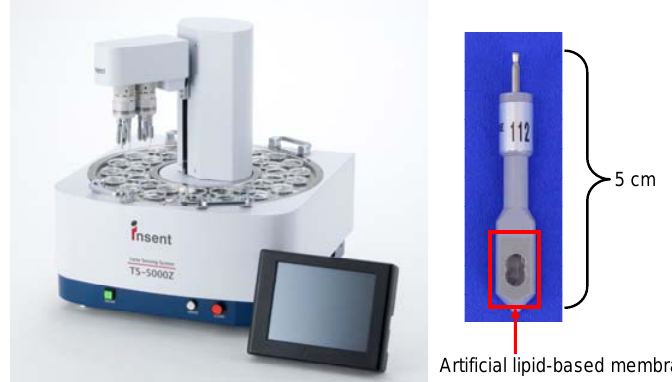
Figure 4. TS-5000Z Taste Sensing System. Left: TS-5000Z, Right: Taste